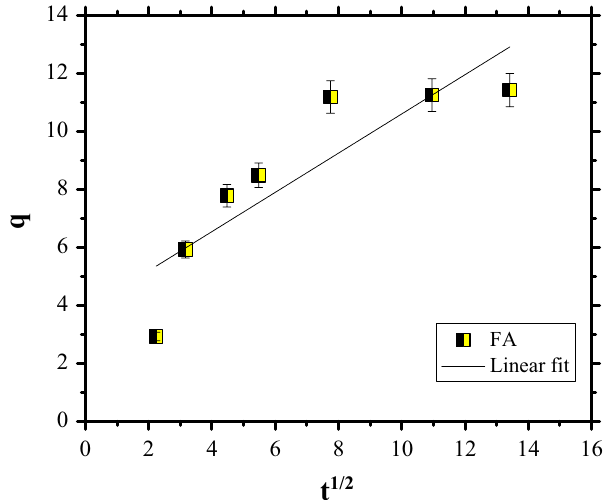
Figure 13. Intraparticle diffusion model of Congo Red dye adsorption.